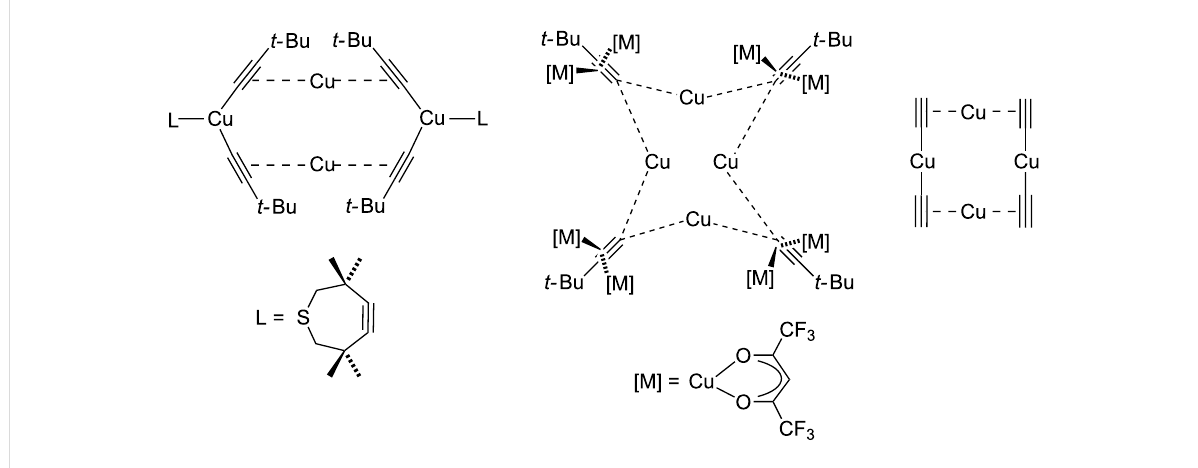
Figure 7: Tetranuclear copper acetylide complexes as reported by Weiss (left) [176] and Tasker (middle) [185] and model of tetranuclear copper(I) acetylides as resting state for mechanistic DFT studies [186].